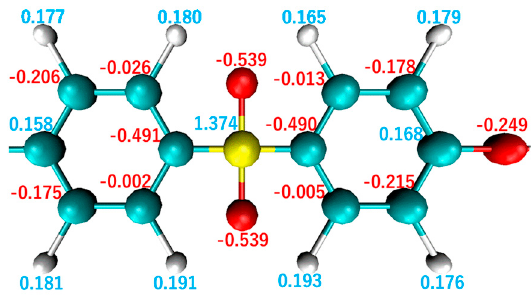
Figure 5. Charge distribution in a monomer of PES.